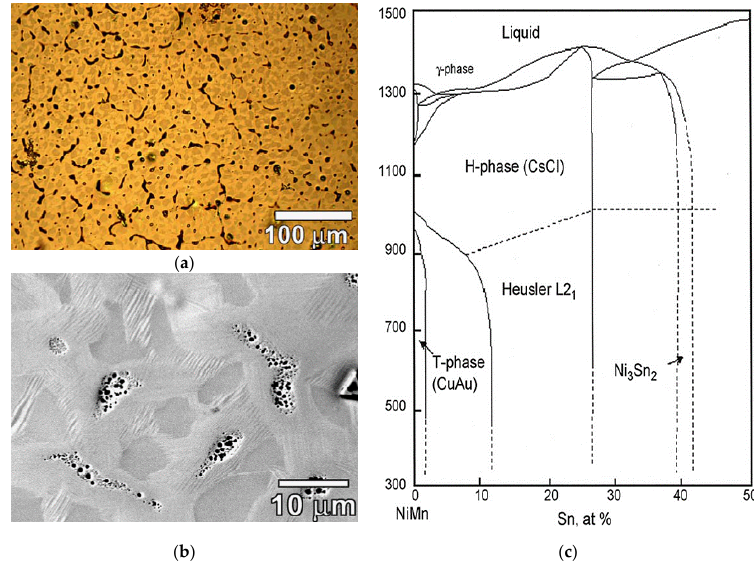
Figure 6. ( a ) Optical micrograph of as ‐ cast Ni 44.5 Co 5.5 Mn 39.5 Sn 10.5 alloy [73], with copyright permission from © Elsevier ; ( b ) SEM micrograph of the as ‐ cast alloy [73], with copyright permission from © Elsevier ; ( c ) vertical section of phase diagram [62], with copyright permission from © Elsevier BV .